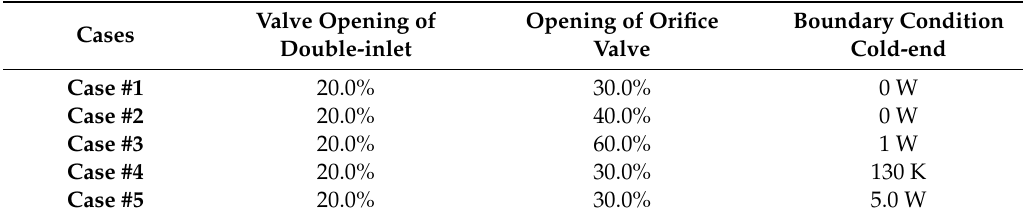
Table 2. Percentage of valve opening.